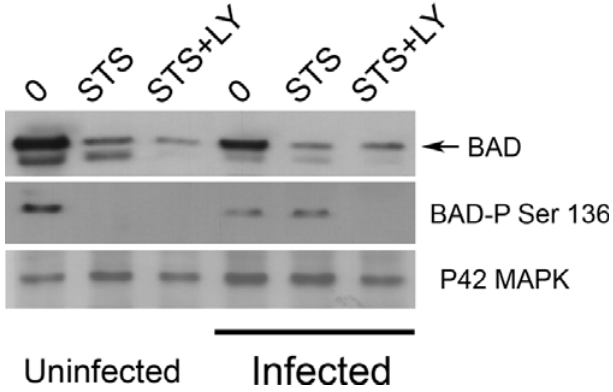
Figure 6. Effect of PI3K on BAD Phosphorylation during C. trachomatis Infection Cells over-expressing BAD were infected with C. trachomatis at an MOI of 1.0 for 26 h or mock-infected, and then incubated with 50 l M LY294002 (LY) or control buffer for 6 h before treating with 2 l M STS overnight. Cells were then collected for Western immunoblotting and analyzed for total BAD protein (top row), phosphorylation of BAD on residue Ser 136 (middle row), or total P42 MAP kinase protein (bottom row), as described in Materials and Methods. C. trachomatis infection led to a decrease in the level of BAD, which was further decreased by STS treatment. Pre- incubation with LY294002 did not further alter the level of total BAD (top row). STS-treatment of uninfected cells caused complete dephosphor- ylation of BAD, but BAD remained phosphorylated after STS-treatment of infected cells (middle row). However, pre-incubation of infected cells with LY294002 before treatment with STS resulted in complete dephosphorylation of BAD (middle row). Infection had no effect on total P42 MAP kinase protein levels (bottom row). One experiment of three representative experiments performed on separate days is shown. DOI: